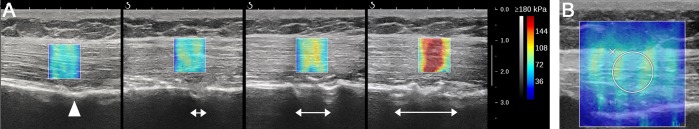
A) SWE images of elongated deltoid muscle. The colored regions represent the SWE modulus map with the scale to the right of the figure. Arrow head represents the osteotomized region without elongation (0 mm). Arrows represent the extent of elongation (+5, +10, and +15 mm). B) A circular region of interest (ROI) was used to obtain SWE values that included the entire thickness of the muscle.